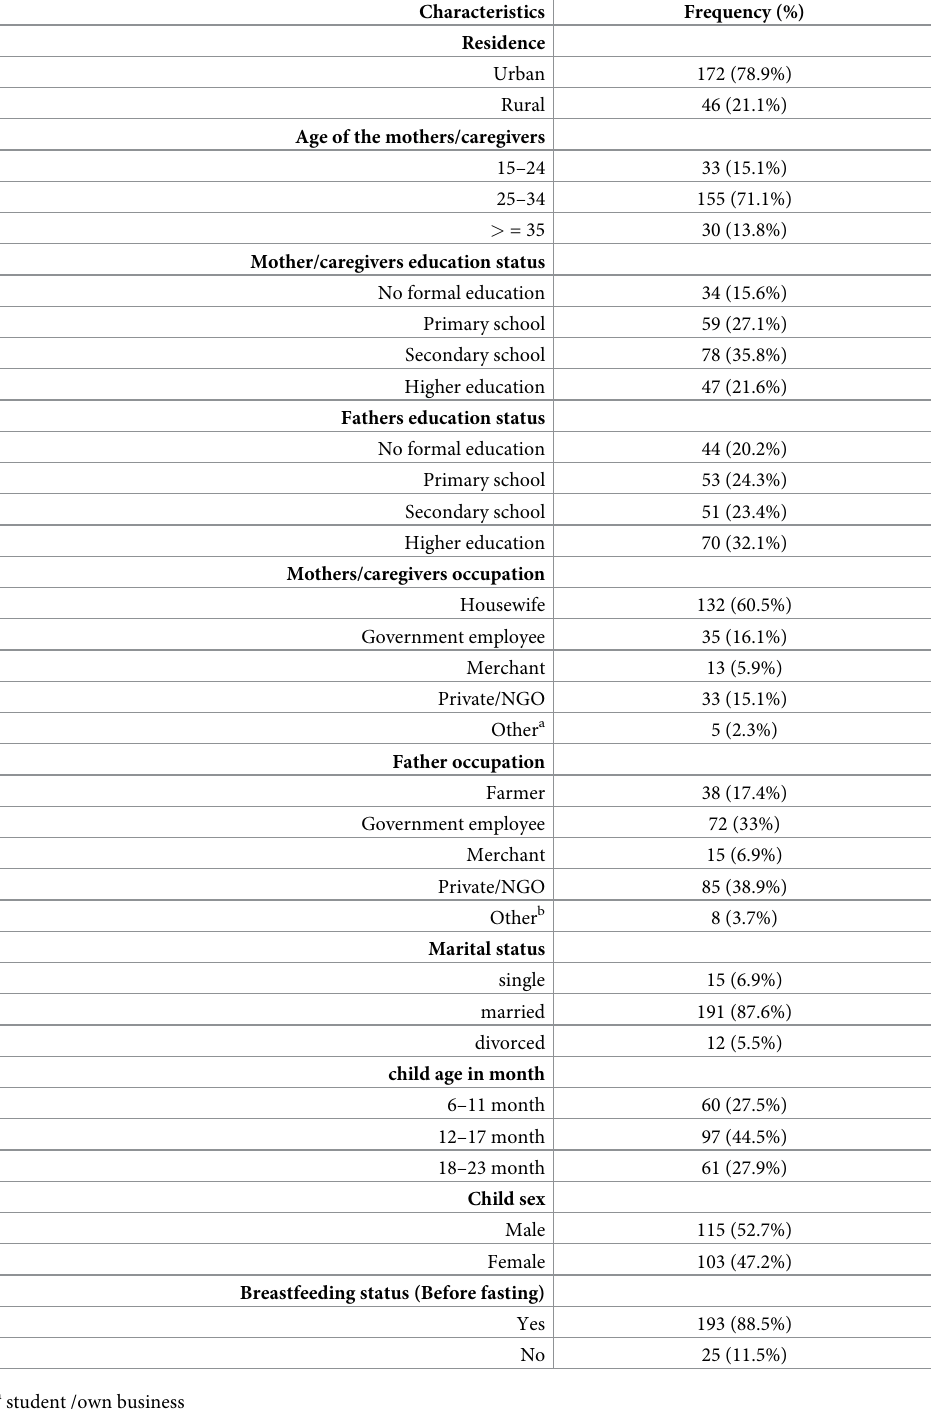
Table 1. Socio-demographic, maternal and child characteristics (n = 218) at baseline (Before fasting period) in Debrebirhan, North Shewa Zone Ethiopia (February-June,